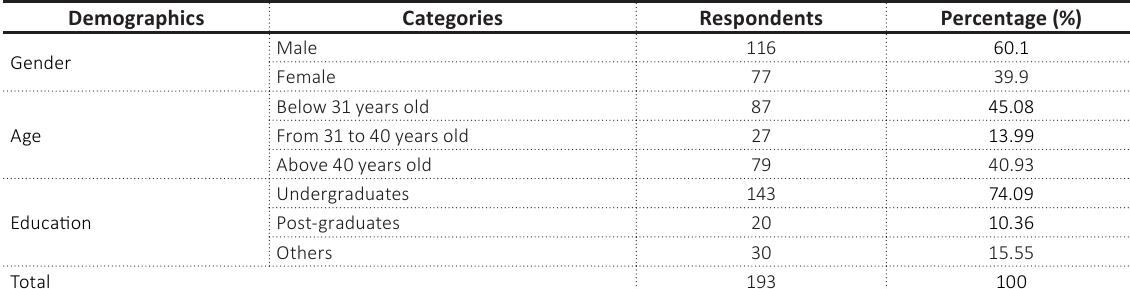
Table 1. Demographics of the